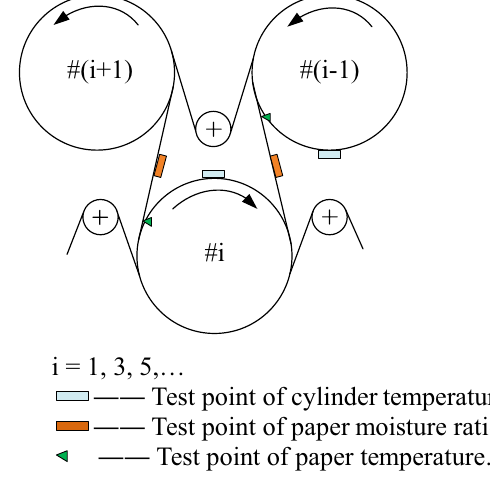
Fig. 2 Test points of operating parameters in multi-cylinder dryer sections